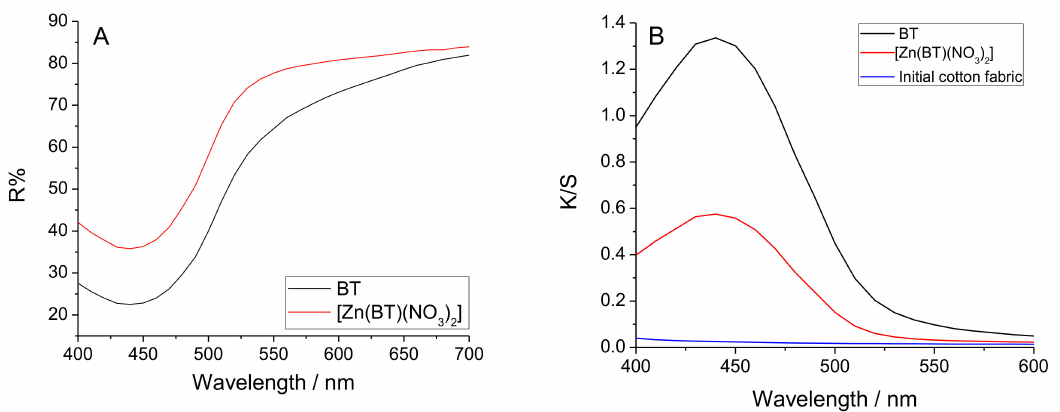
Figure 4. Reflectance ( A ) and K / S (ratio of the absorption coe ffi cient (K) and the coe ffi cient of scattering of the coloured materials (S)) ( B ) of cotton fabric treated with BT and [Zn(BT)(NO 3 ) 2